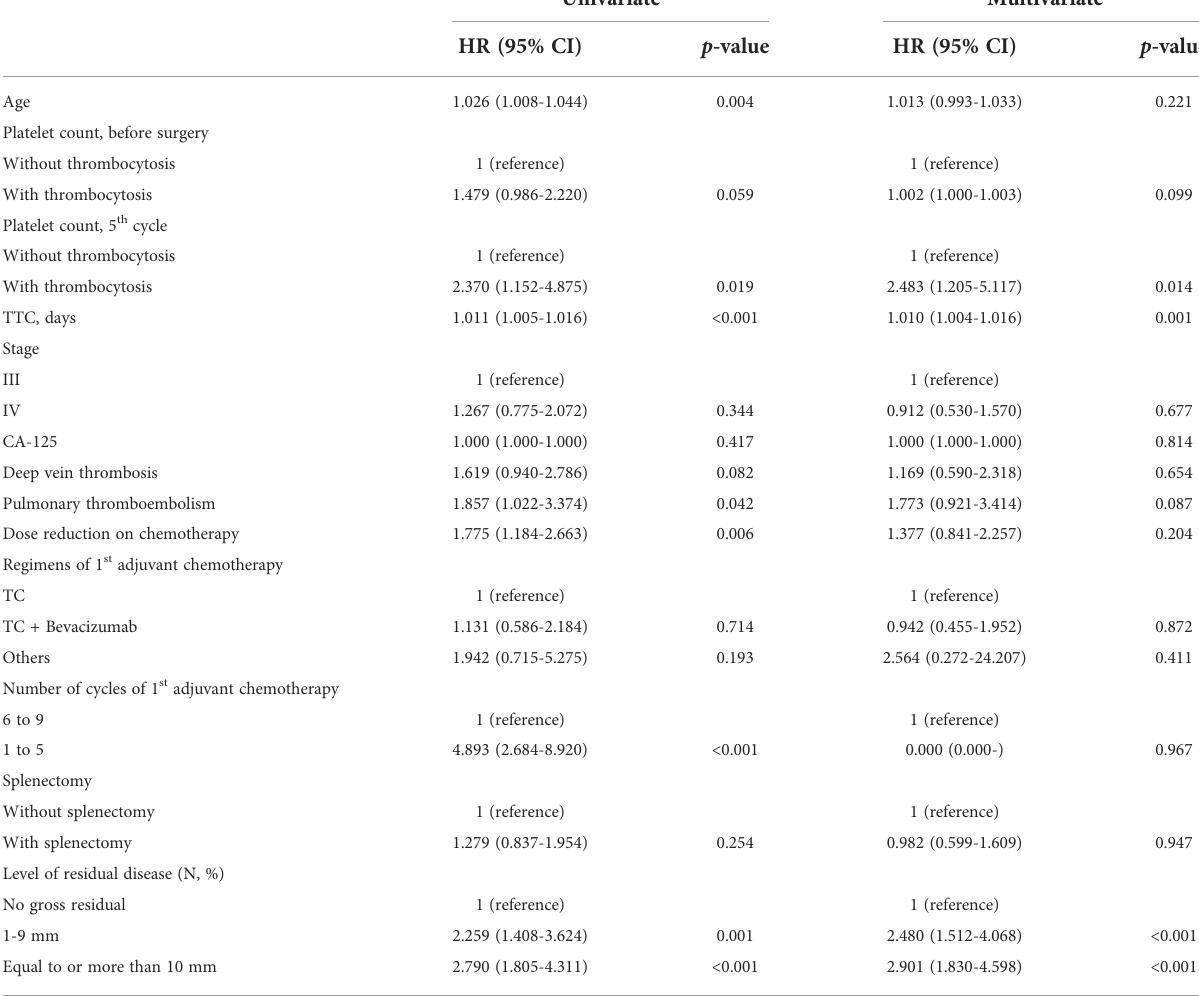
TABLE 4 Univariate and multivariate analysis for overall